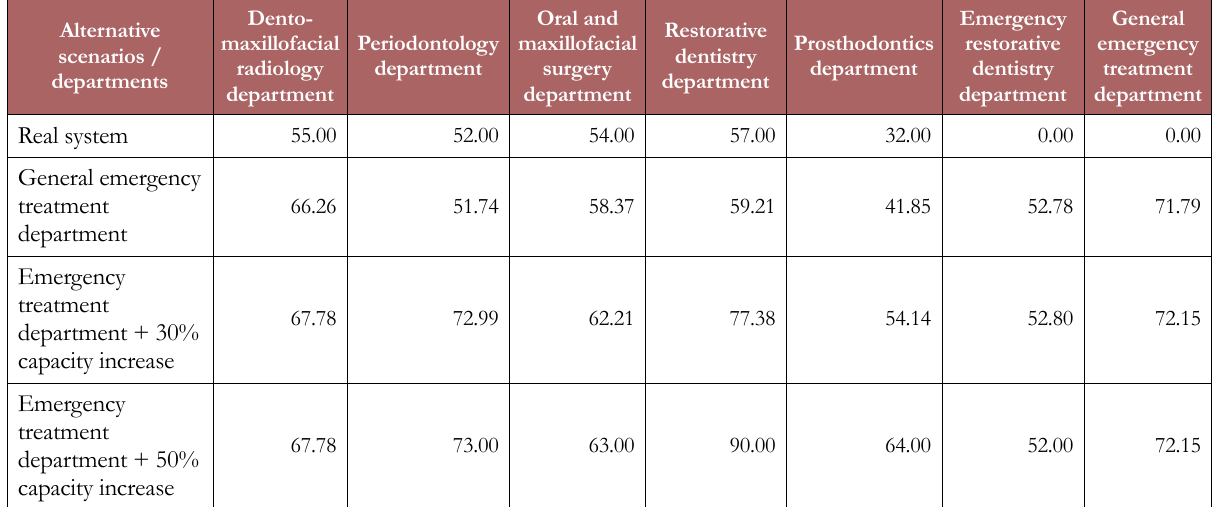
Table 2. The capacity utilization rates of different suggestion processes